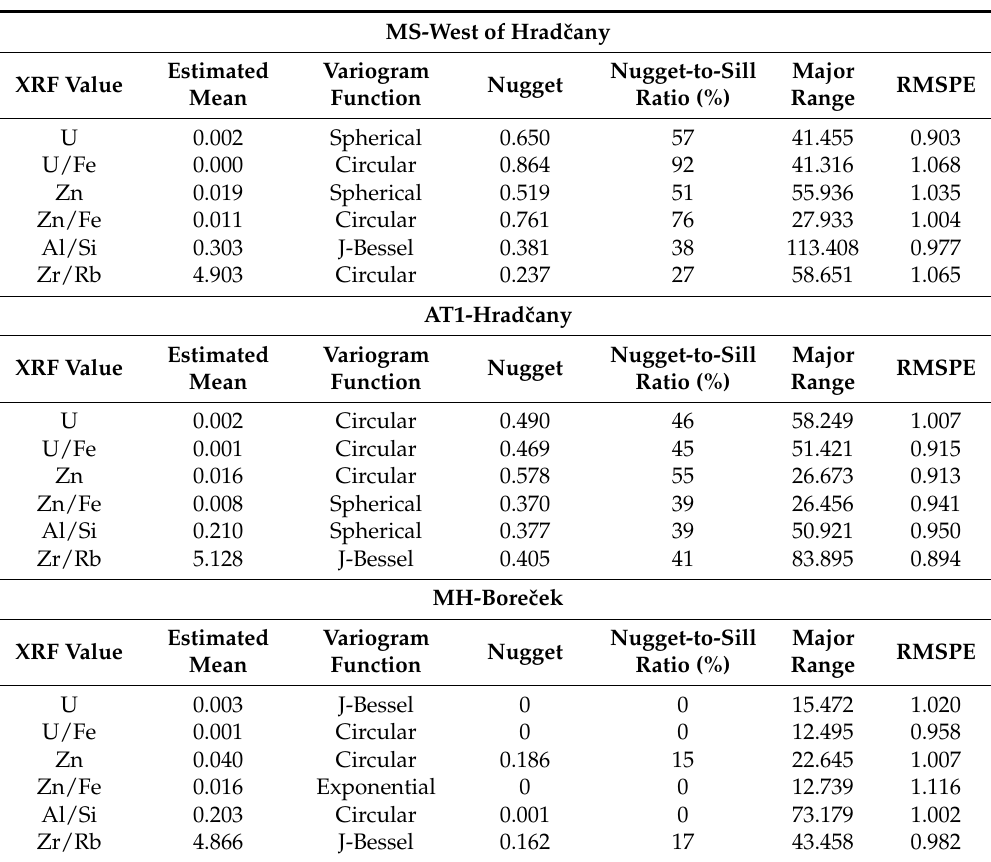
Table 1. Parameters of geostatistical interpolation (simple